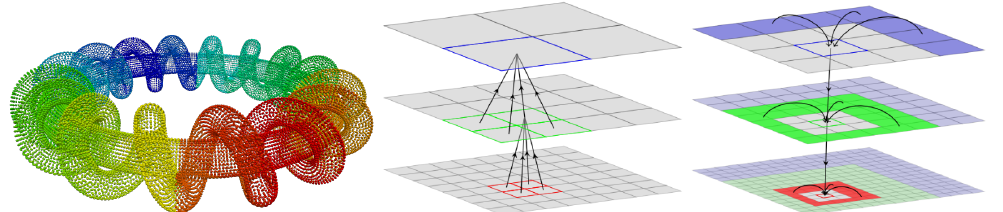
Figure 3. Geometric clusters of the same partition level ( left ) and up and downward passes in the multilevel scheme ( right